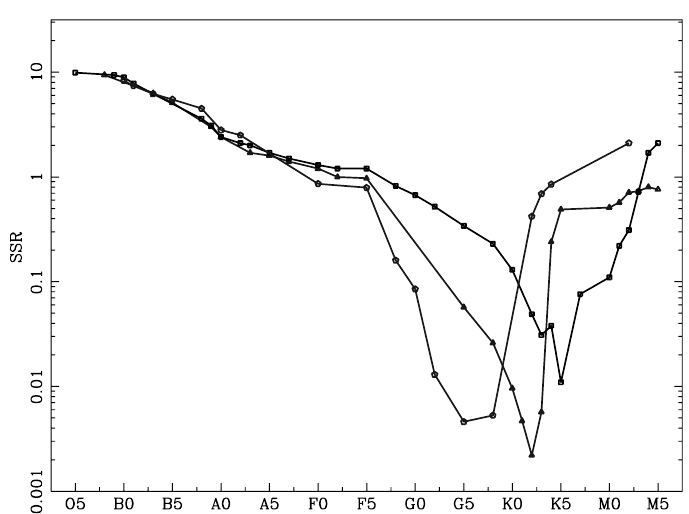
Fig. 4. The sum of squared residuals obtained for the star HD 1796 (K3III) vs. the model spectral type. The circles, triangles, and squares indicate supergiants, giants, and dwarfs,